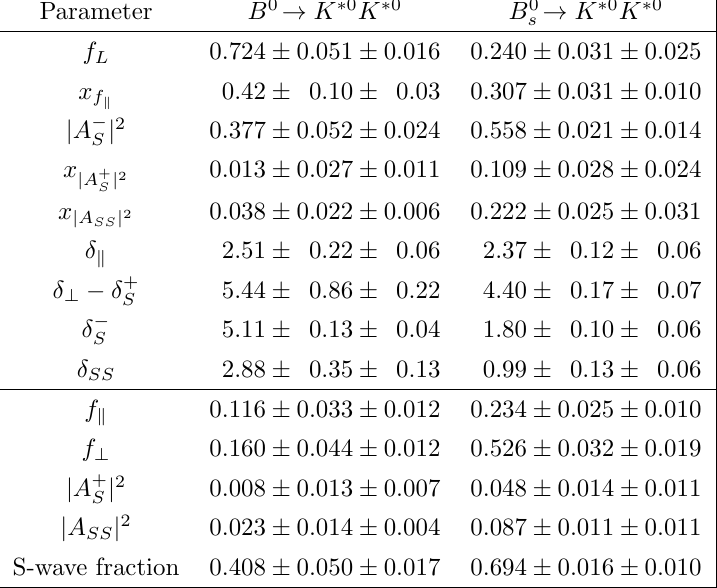
Table 4 . Results of the amplitude analysis of B 0 ( K + (cid:25) (cid:0) )( K (cid:0) (cid:25) + ) and B 0 ( K + (cid:25) (cid:0) )( K (cid:0) (cid:25) + ) s ! ! decays. The observables above the line are directly obtained from the maximum-likelihood (cid:12)t whereas those below are obtained from the former, as explained in the text, with correlations accounted for in their estimated uncertainties. For each result, the (cid:12)rst quoted uncertainty is statistical and the second systematic. The estimation of the latter is described in section